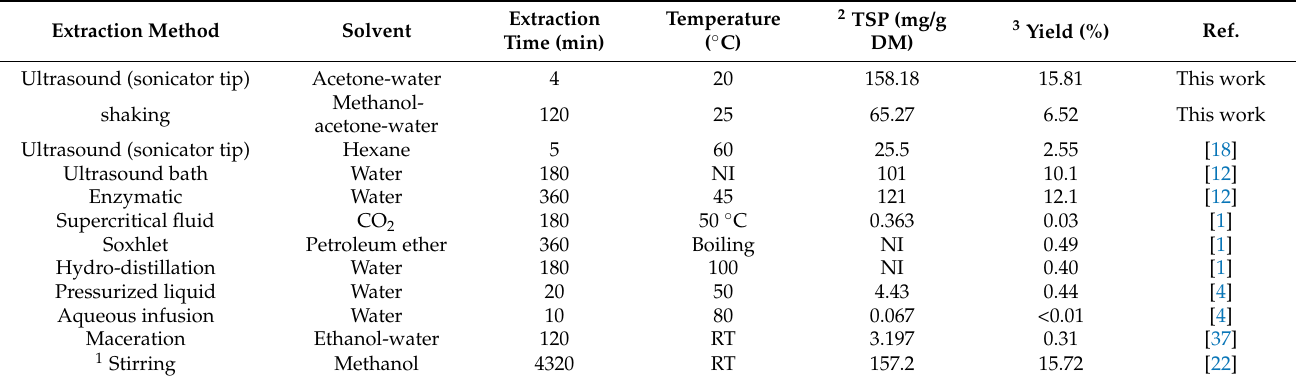
Table 5. Review of the total soluble phenols content from Psidium cattleianum leaves reported according to different extraction